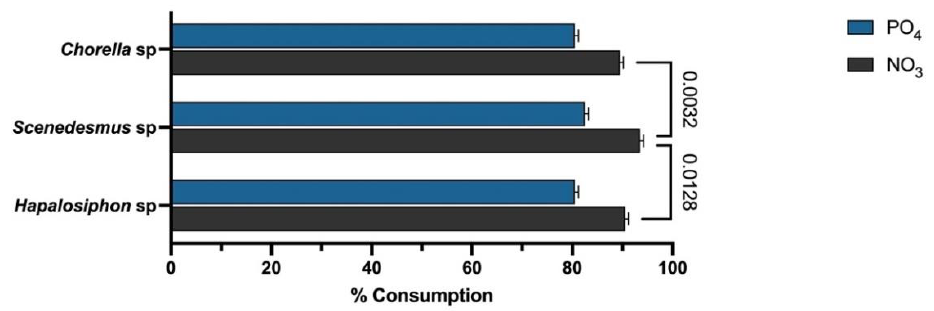
Figure 2. Nitrate and phosphate consumption by the studied strains.